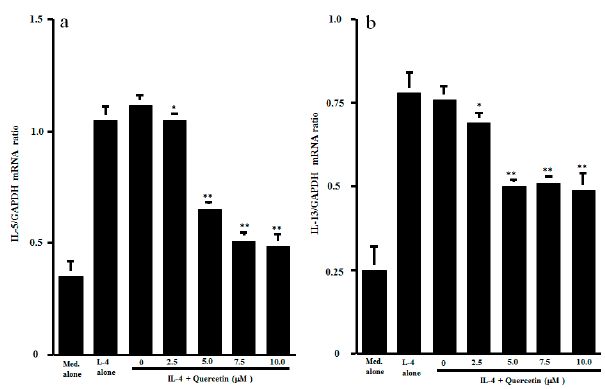
Figure 4. Influence of quercetin on mRNA expression for Th2-type cytokines in vitro. CD4 + T cells (1 × 10 6 cells / mL) were stimulated with 10.0 ng / mL IL-4 in the presence of various concentrations of quercetin for 4 h. mRNA expression for IL-5 ( a ) and IL-13 ( b ) was examined by real-time RT-PCR. The results were expressed as the mean cytokine / GAPDH ± SE of five subjects. * p > 0.05 versus IL-4 alone; ** p < 0.05 versus IL-4